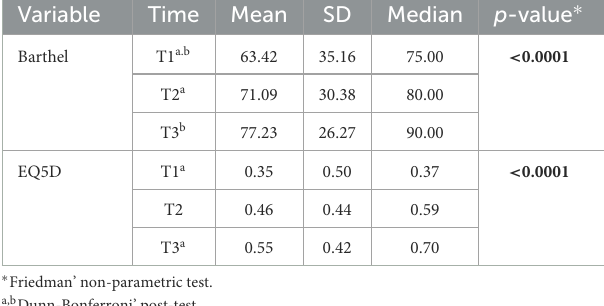
TABLE 1 Evolution of functionality and quality of life over